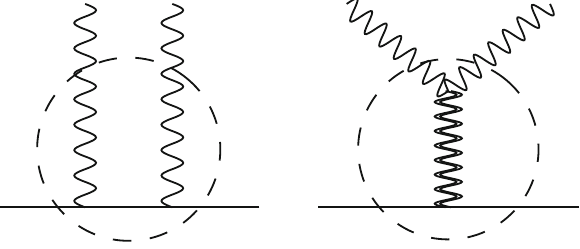
Fig. 10 Two diagrams with the same external legs and different cou- pling constants